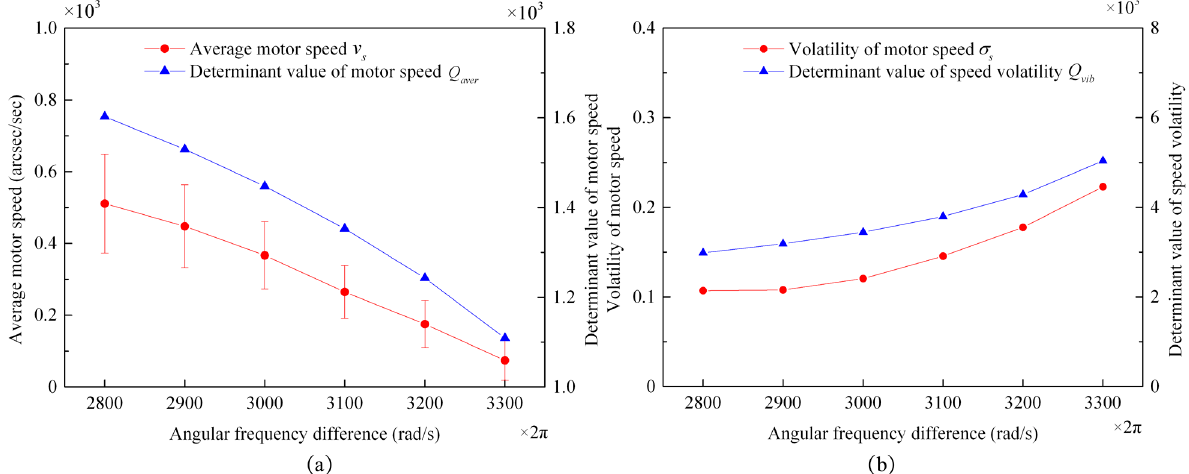
Figure 21. Simulation diagram of characteristic variables changing with frequency difference: ( a ) a simulation diagram of the motor’s average speed, v s , and the motor’s average speed determinant, Q over , changing with the frequency difference; and ( b ) a simulation diagram of the speed volatility determinant, Q over , and the speed volatility, σ s , changing with the frequency difference.